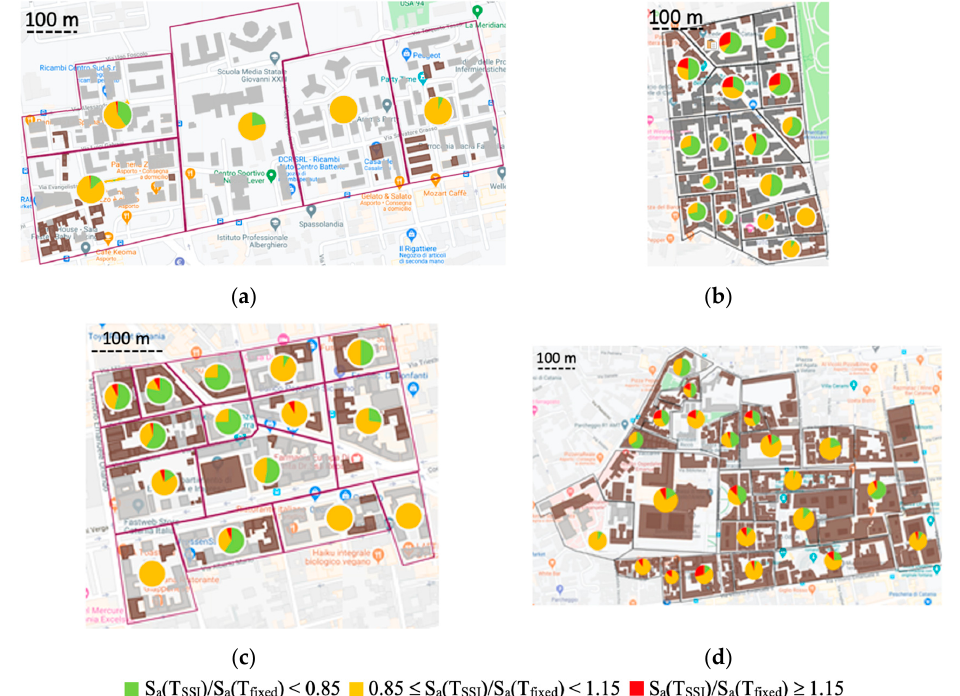
Figure 11. Spatial distribution of S a ( T SSI ) / S a ( T fixed ) ratios for the 1990 seismic input: ( a ) west area; ( b ) northeast area; ( c ) north Old Town; ( d ) south Old